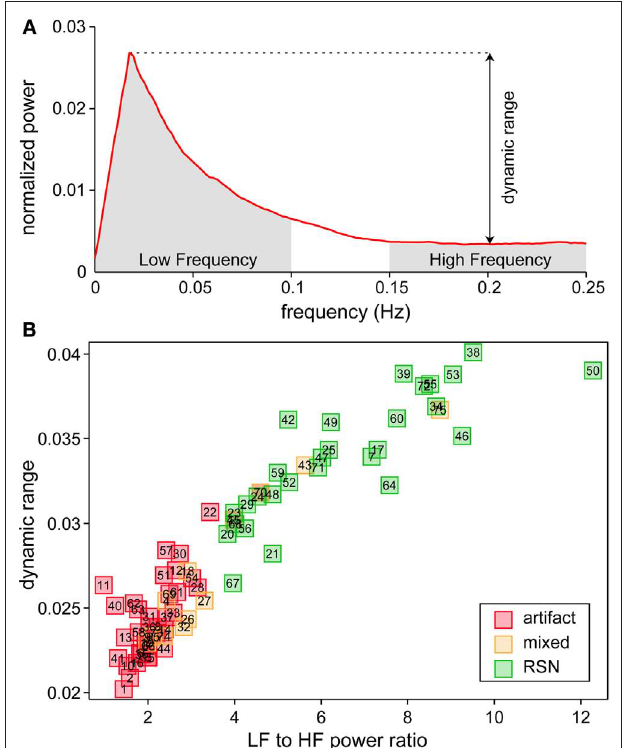
FIGuRe 3 | Spectral characteristics of component TCs. (A) Average power spectrum of independent component (IC) 52 illustrating the features used to compute dynamic range and low frequency (LF) to high frequency (HF) power ratio. (B) Scatter plot of LF to HF power ratio versus dynamic range for all components. Along with spectral characteristics, SMs were used to categorize components as RSNs (green), artifacts (red) or mixture of the two